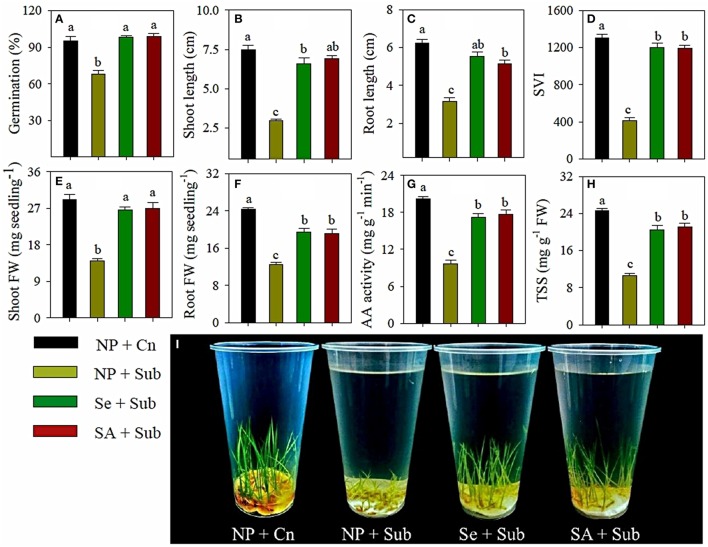
Influence of seed priming on (A) final germination, (B) shoot length, (C) root length, (D) seedling vigor index, (E) shoot fresh weight, (F) root fresh weight, (G) α-amylase activity, and (H) total soluble sugar content of rice under submergence stress. (I) Pictorial view of the primed and non-primed rice seedlings under submergence stress at 7 DAS. Data (A–H) represent mean ± SE of six replicates. Different small letters above the mean bars represents the significant difference among treatments at LSD < 0.05. NP, non-primed; Se, 60 μM selenium priming; SA, 100 mg L−1 salicylic acid priming; Sub, submergence, FW, fresh weight.